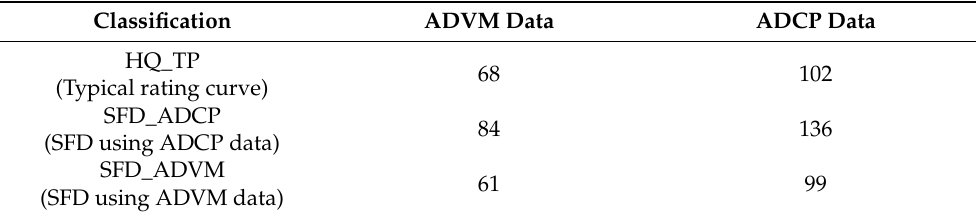
Table 4. Estimated RMSE of the hydrograph from July to September, reproduced considering the rating curves with ADCP data and ADVM data measured from July to